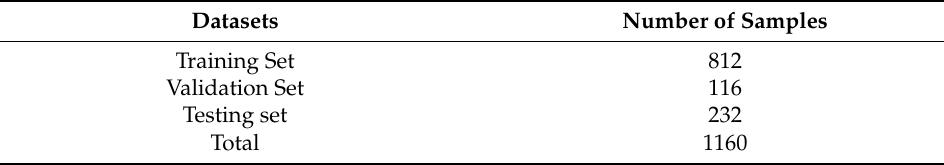
Table 2. SSDD distribution.